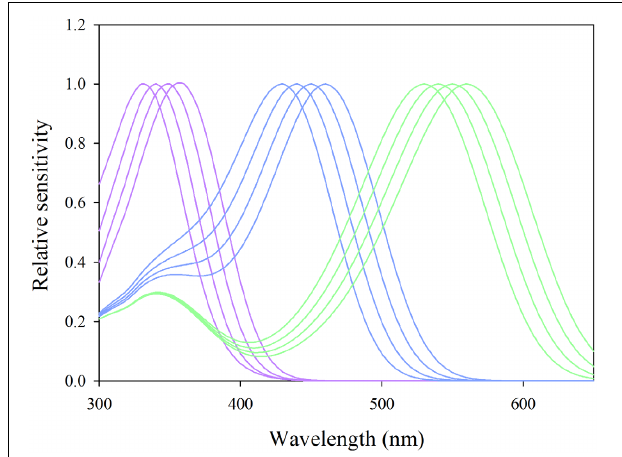
FIGURE 3 | Putative sensitivities of UV-blue-green photoreceptors modeled with the Stavenga template for photopigment A1 used in the calculation of photon catches in Equation (3). Purple curves represent sensitivities of putative UV receptors for α -band maxima set at 330, 340, 350, and 360nm, the blue curves those of blue receptors for α -band maxima set at 430, 440, 450, and 460nm and the green curves those of green photoreceptors with α -band maxima set at 530, 540, 550, and